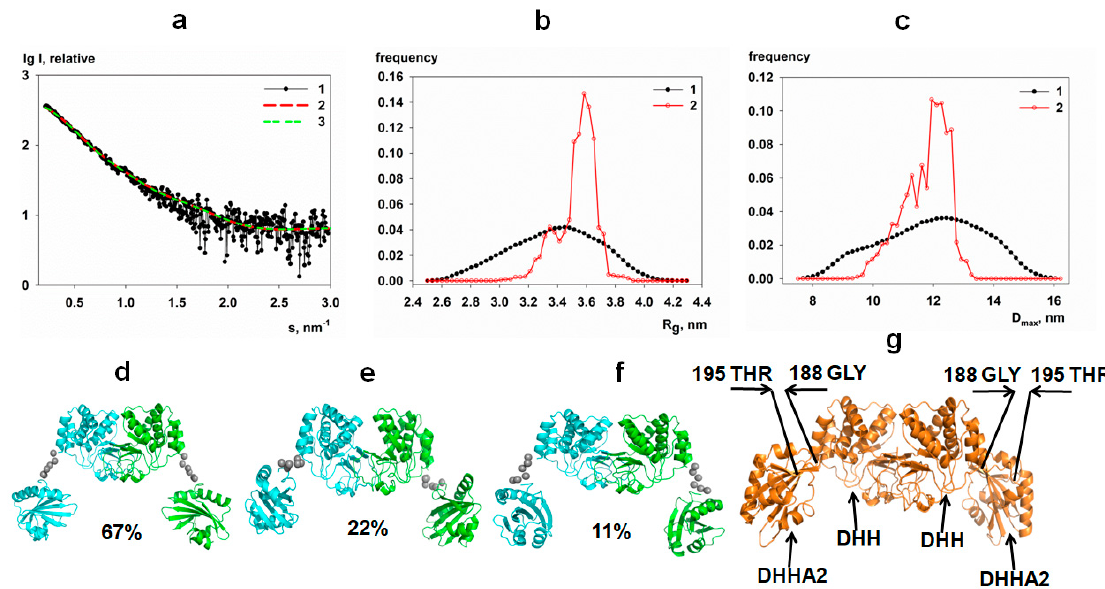
Figure 1. Small-angle X-ray scattering (SAXS) analysis of the catalytic domain of dh-PPase (dh-PPase ∆ CDC): ( a ) Experimental data, curve 1; computed fit from the EOM selected ensemble of conformers, curve 2; OLIGOMER fit from the dh-PPase ∆ CDC models displayed in (d-f), curve 3; ( b , c ) distribution histograms of R g and D max in the generated random pool (curve 1) and in the ensemble of the selected conformers (curve 2); ( d – f ) A set of the dh-PPase ∆ CDC conformers with added flexible fragments (grey spheres) corresponding to the histogram peaks. The volume fraction of each species is indicated. ( g ) The crystallographic model of canonical PPase of family II (PDB ID: 1k23).